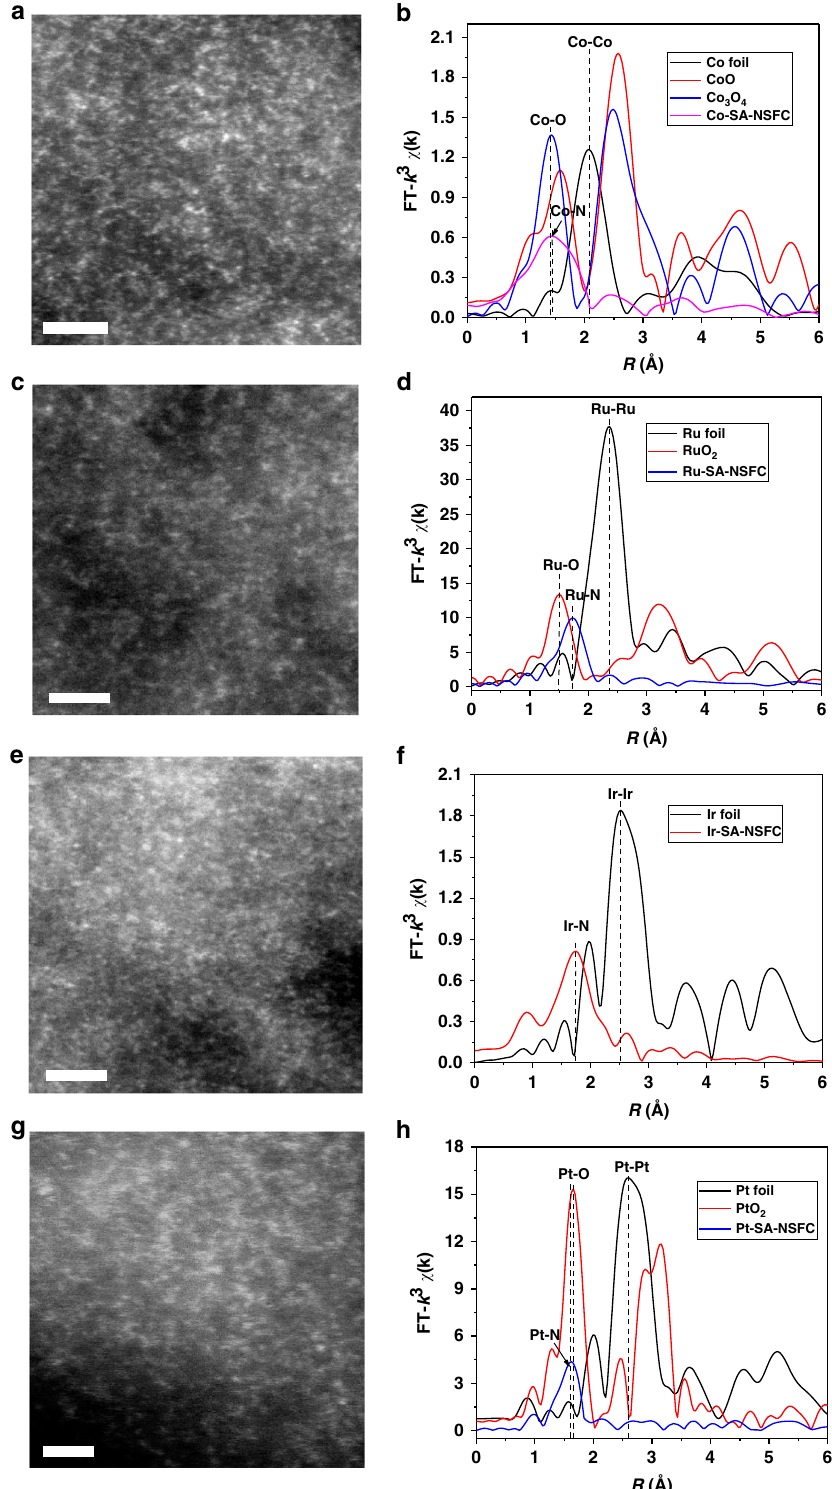
Fig. 3 Characterization of M-SA-NSFCs with other metals. a , c , e , g AC-HAADF-STEM images and b , d , f , h EXAFS experimental data: a , b Co-SA-NSFC; c , d Ru-SA-NSFC; e , f Ir-SA-NSFC; and g , h Pt-SA-NSFC. Scale bar: 2